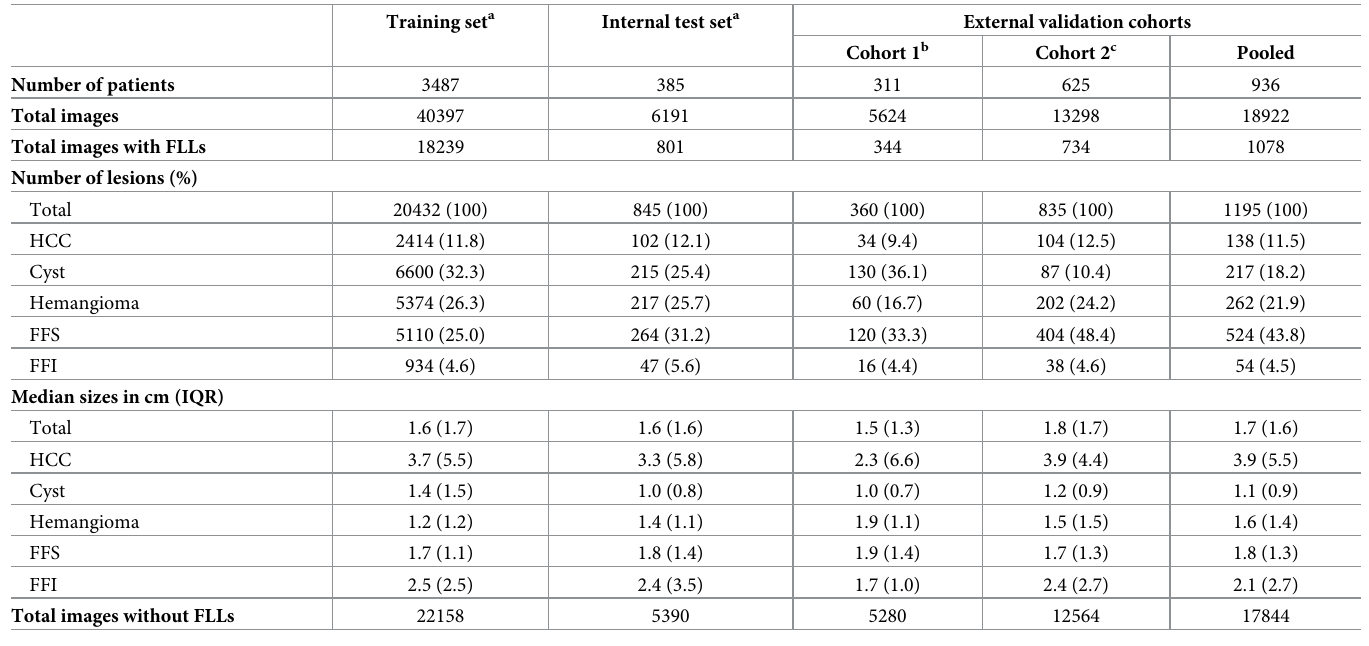
Table 1. Number of USG images from 3 participating hospitals, along with allocation of images for AI training and performance